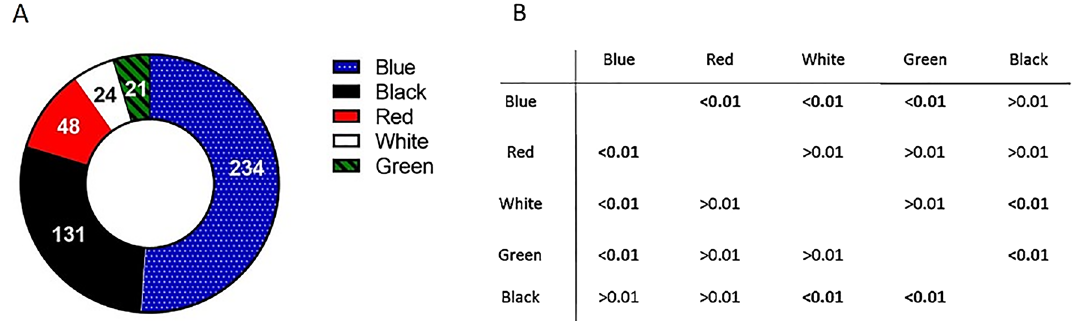
Figure 3. ( A ) Abundances of large microplastics (lMP) items by colour observed in the cases of caddisflies sampled from River Licenza (Latium, Italy). ( B ) In the table, p values of Dunn’s post hoc test show the pairwise comparison of the abundances of lMP items of different colours. Significant values (Kruskal Wallis, p < 0.01) are in bold. The images ( A ) and ( B ) are obtained by the software GraphPad Prism (ver. 8.4.2, https ://www.graph pad. com/suppo rt/faq/prism -842-relea se-notes